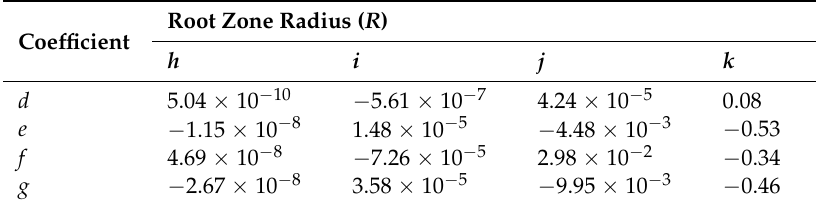
Table 1. The coefficients of the root zone radius